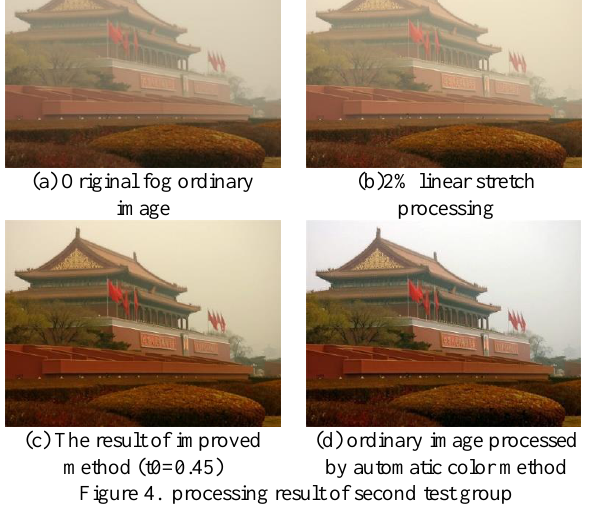
Figure 4. processing result of second test group